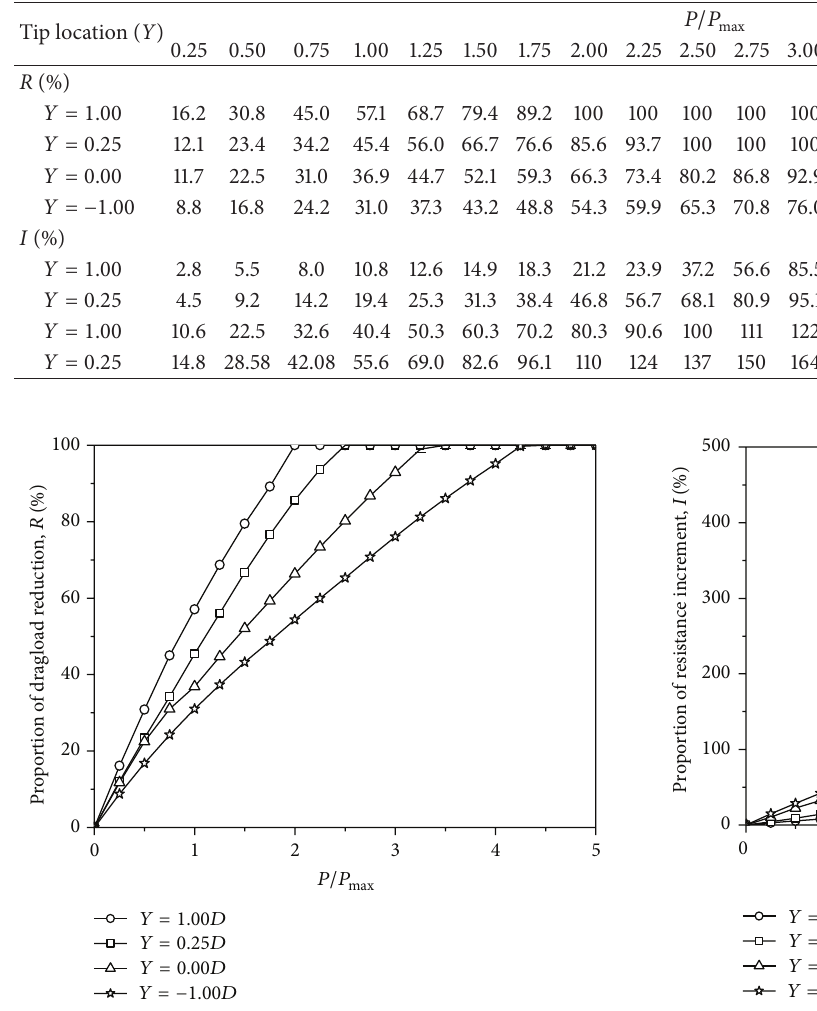
Figure10:Computedendresistanceincrementundersurchargeand axial